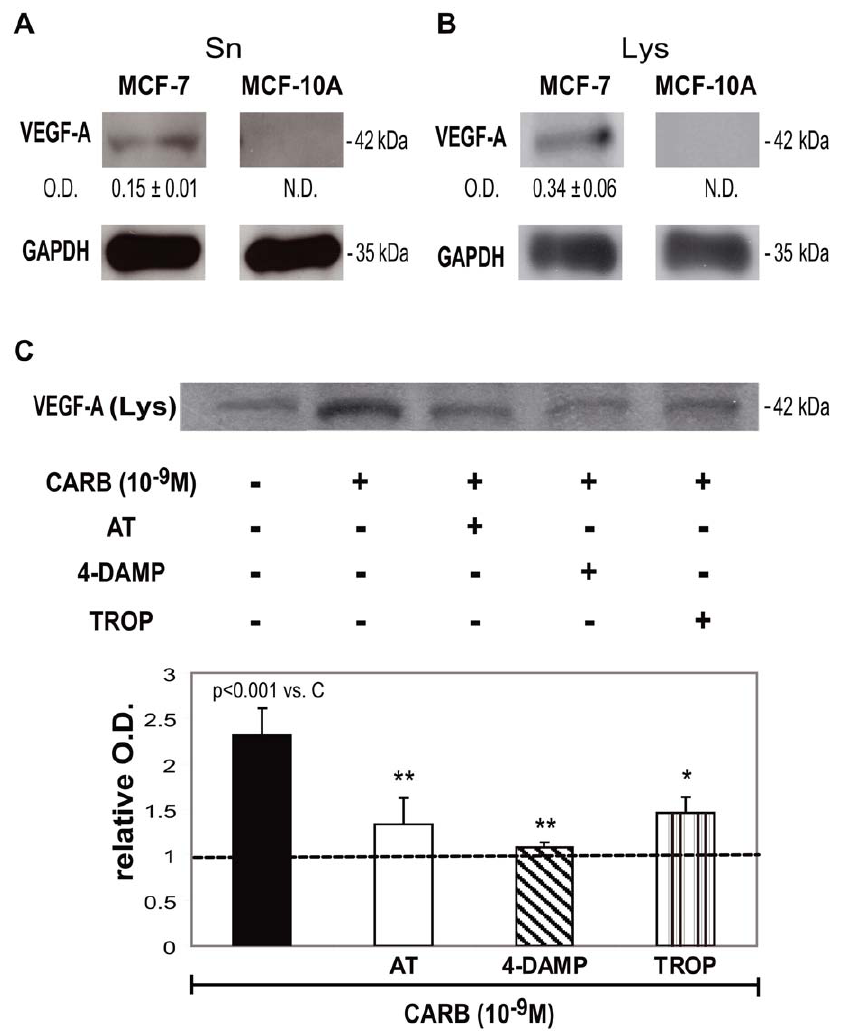
Figure 1. Effect of carbachol on VEGF-A expression in MCF-7 cells. Western blot assays were performed in A) supernatants (Sn) and B) lysates (Lys) from MCF-7 and MCF-10A cells. Optical density (O.D.) of the bands was calculated by densitometric analysis, and values were relativized to the expression of glyceraldehyde-3-phosphate dehydrogenase (GAPDH). N. D. not detectable. One representative experiment of three is shown. Values are mean 6 S.E.M. of three experiments. Molecular weights are indicated on the right. C) MCF-7 cells were treated for 1 h with 10 2 9 M carbachol (CARB) in the absence or presence of 10 2 8 M atropine (AT), 4-diphenylacetoxi-N-methylpiperidine (4-DAMP), or tropicamide (TROP) and VEGF-A expression was measured in Lys. Densitometric analysis of the bands is shown in lower panel. Values were relativized to the expression of VEGF-A in MCF-7 cells without treatment, considered as 1, and is represented by a dotted line. Molecular weights are indicated on the right. Values are mean 6 S.E.M of three experiments. * p , 0.1; ** p , 0.01 vs . CARB.